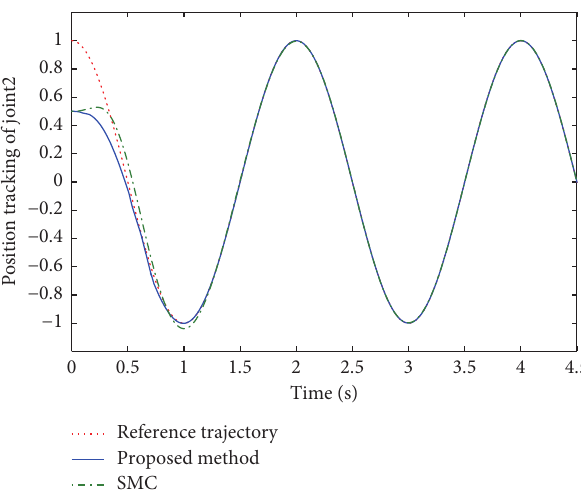
Figure 4: The estimation errors of q